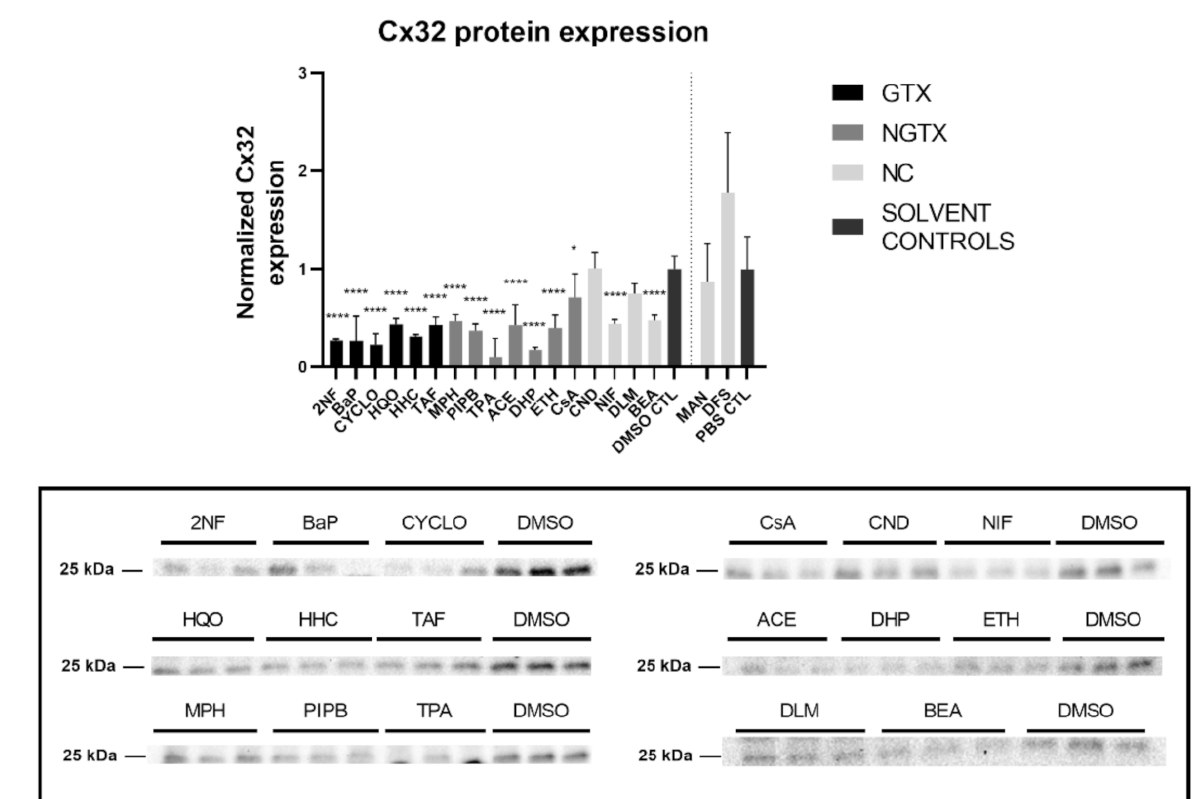
Figure 5. Cx32 protein expression in human hepatoma HepaRG cells exposed GTX, NGTX, and NC chemicals. Human hepatoma HepaRG cells ( n = 3 and N = 1) were exposed to GTX, NGTX, and NC chemicals for 72 h. Densiometric quantitative data were obtained via Image Lab 6.0.1 software (Bio-Rad, Hercules, CA, USA). Data were normalized to the total protein loading (Figure S4) according to Bio-Rad’s instructions [40] and expressed as a ratio to their respective solvent control (DMSO CTL or PBS CTL). Significant difference compared to the solvent control (DMSO CTL or PBS CTL) was calculated with a parametric one-way ANOVA followed by a Dunnett’s post-hoc test to correct for multiple comparisons. Data are expressed as mean ± standard deviation with * p ≤ 0.05 and **** p ≤ 0.0001. Only blots containing significantly affected expression patterns are